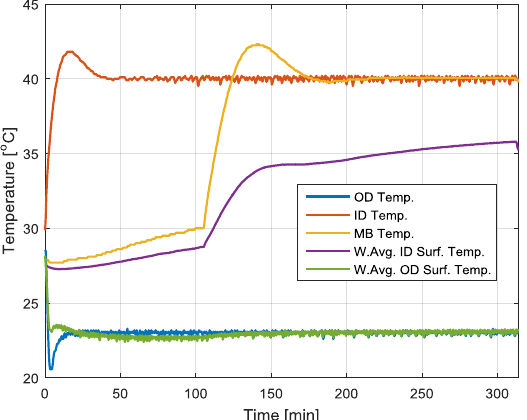
Figure 7. Variation of ID, OD, and MB temperatures with time during Test 1.